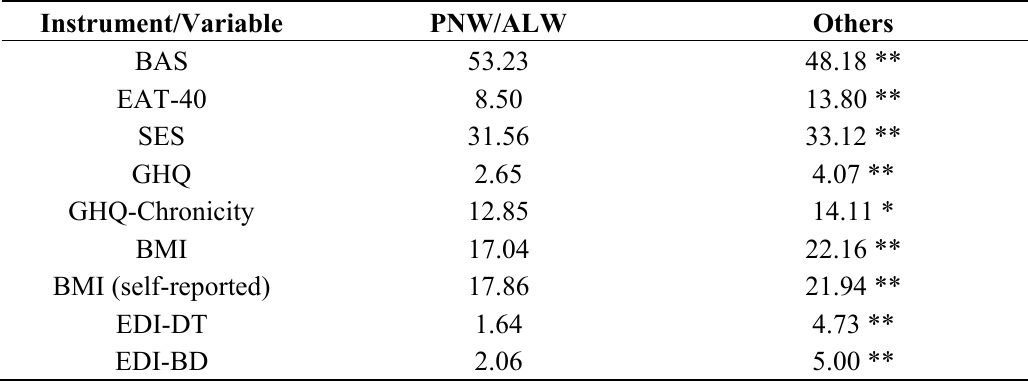
Table 2. Differences between participants who perceived their weight as normal (PNW) but who had an actual low weight (ALW) and the rest of individuals.